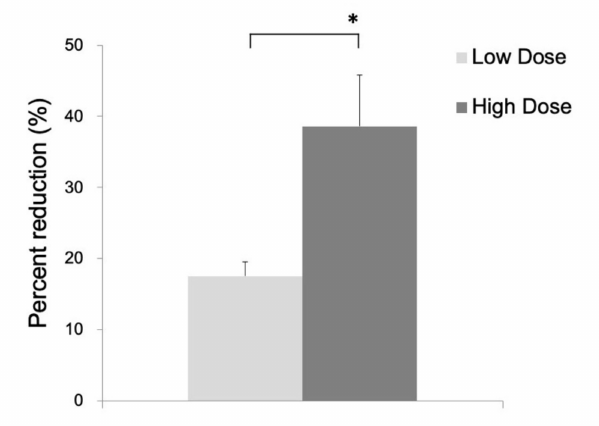
Figure 3. Percent reduction of 14 C-acetate in the ipsilateral as compared to the contralateral side in the low-dose group (17.5 ± 2.0%) and high-dose group (38.6 ± 7.2%). Data are expressed as mean ± standard deviation. (*, p <